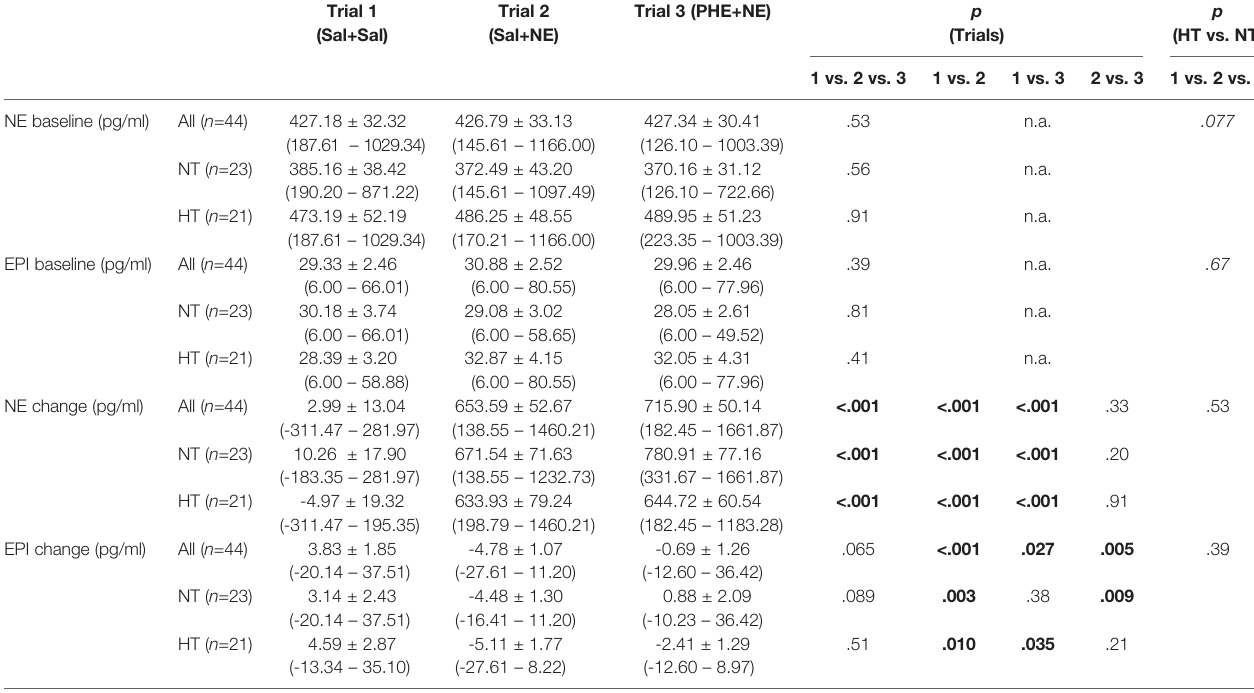
TABLE 3 | Catecholamine levels at baseline and in reaction to infusions.